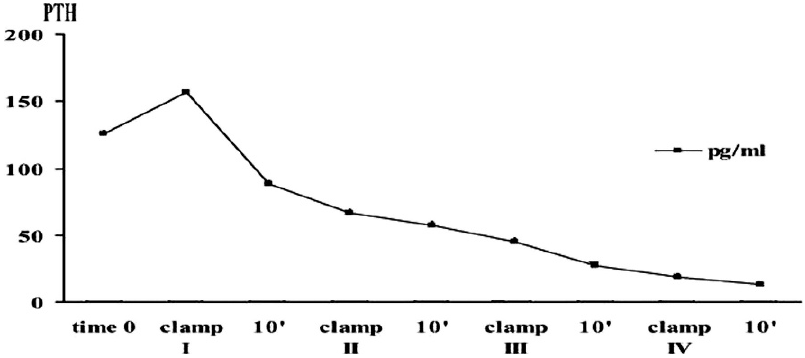
Figure 1 - Blood sampling after the removal of each parathyroid gland until the parathyroid hormone (PTH) values are practically undetectable in patients with